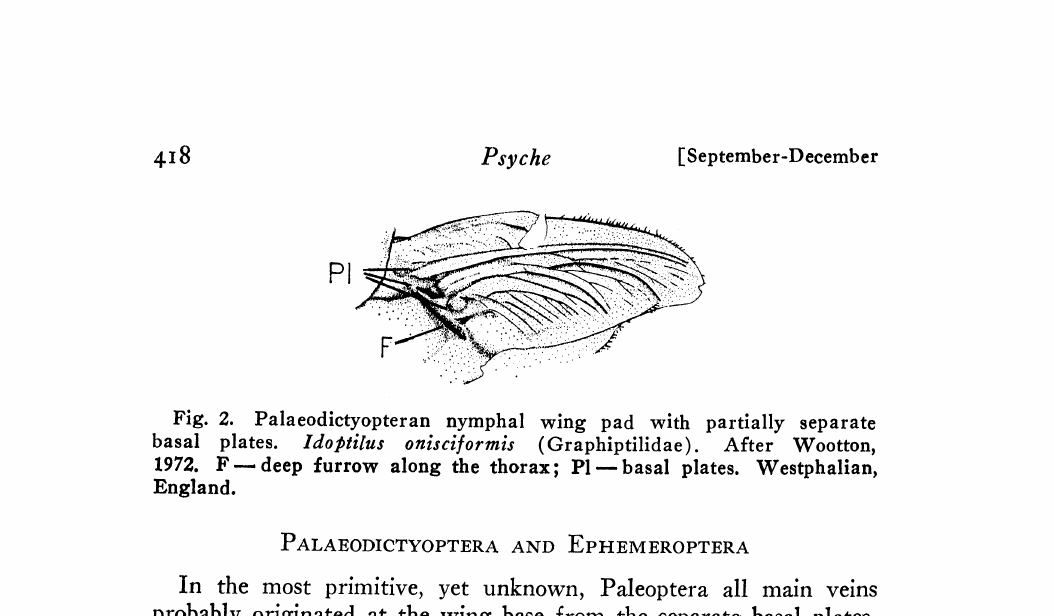
Fig. 2. Palaeodictyopteran nymphal wing pad with partially separate basal plates. Idoptilus onisci[ormis (Graphiptilidae). After Wootton, 1972. F--deep furrow along the thorax; P1---basal plates. Westphalian,